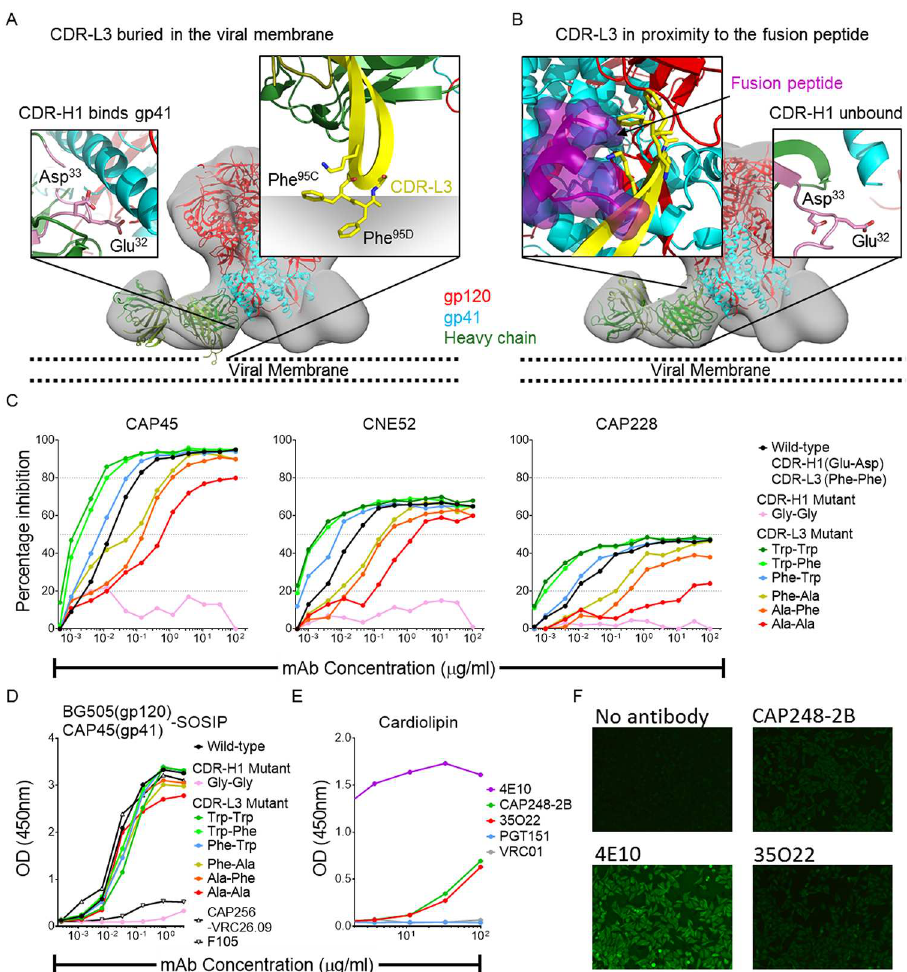
Fig 5. The CAP248-2BCDR-L3 interacts with the viral membrane. Two dockingorientationsfor the CAP248-2B Fab are modelledwith (A) the CDR-L3 in close proximity to the viral membrane, and (B) the CDR-L3in close proximity to the fusion peptide. The trimer is colouredas in Fig 4, and the Fab heavy and light chains shown in forest and olive green respectively,and the approximate location of the viral membraneis indicatedwith dotted lines. In the zoomed panel insets, the CDR-H1 (pink) and CDR-L3(yellow) are shown in their predicted bindinglocationsfor each model. The fusion peptideis colored purpleand shown with surface representation. (C) Neutralization of three heterologous viruses by CAP248-2B and related CDR-H1 and CDR-L3mutants. Percentage inhibitionwas plotted on the y-axis versus antibody concentration on the x-axis. Dotted lines indicatey-axis intersections for IC 80 , IC 50 , and IC 20 . (D) ELISA showingbindingof CAP248-2B and related mutant antibodies to the BG505(gp120)-CAP45(gp41)chimeric SOSIP trimer. Absorbance readingsare plotted on the y-axis and antibodyconcentration on the x-axis. CAP256-VRC26.09 and F105 are used are positive and negativecontrol antibodies. (E) Anti-cardiolipin antibody ELISA, labelledas in D. (F) HEp-2 cell reactivity assays comparinga no antibody control to 50 μ g/mL concentrations of either 4E10 (positivecontrol), 35O22 (negative control), or